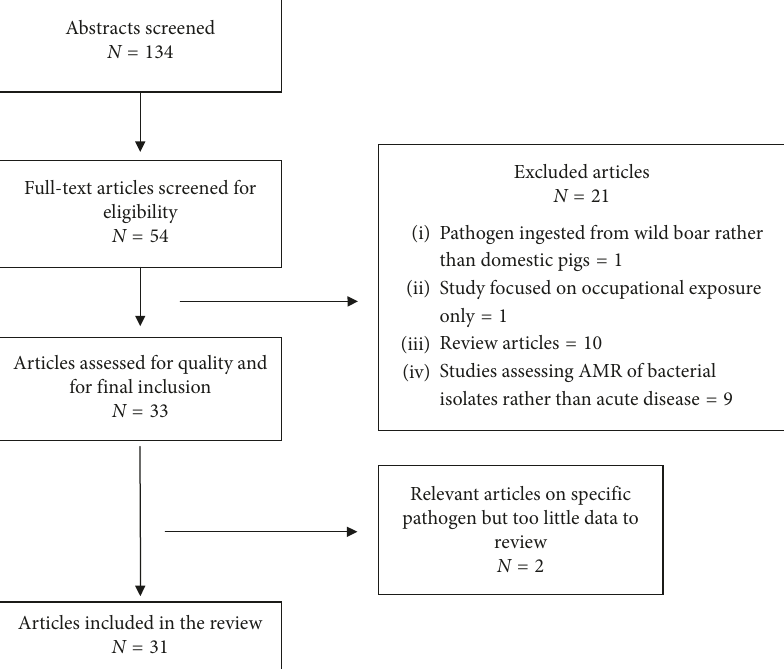
Figure 1: Flow diagram displaying systematic search results and reasons for